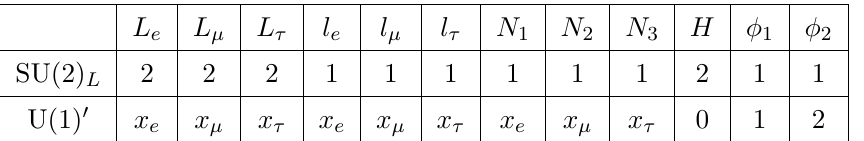
Table 2 . U(1) 0 charges of the model. The charges x (cid:11) , with (cid:11) = e; (cid:22); (cid:28) , can take the values x (cid:11) = 0 ; (cid:0) 1 ; (cid:0) 2, while the charges of the quarks are 1 = 3. In this prescription, we include two scalar (cid:12)elds (cid:30) U(1) 0 , respectively. It is worth to mention that this U(1) 0 interaction is not (cid:13)avor